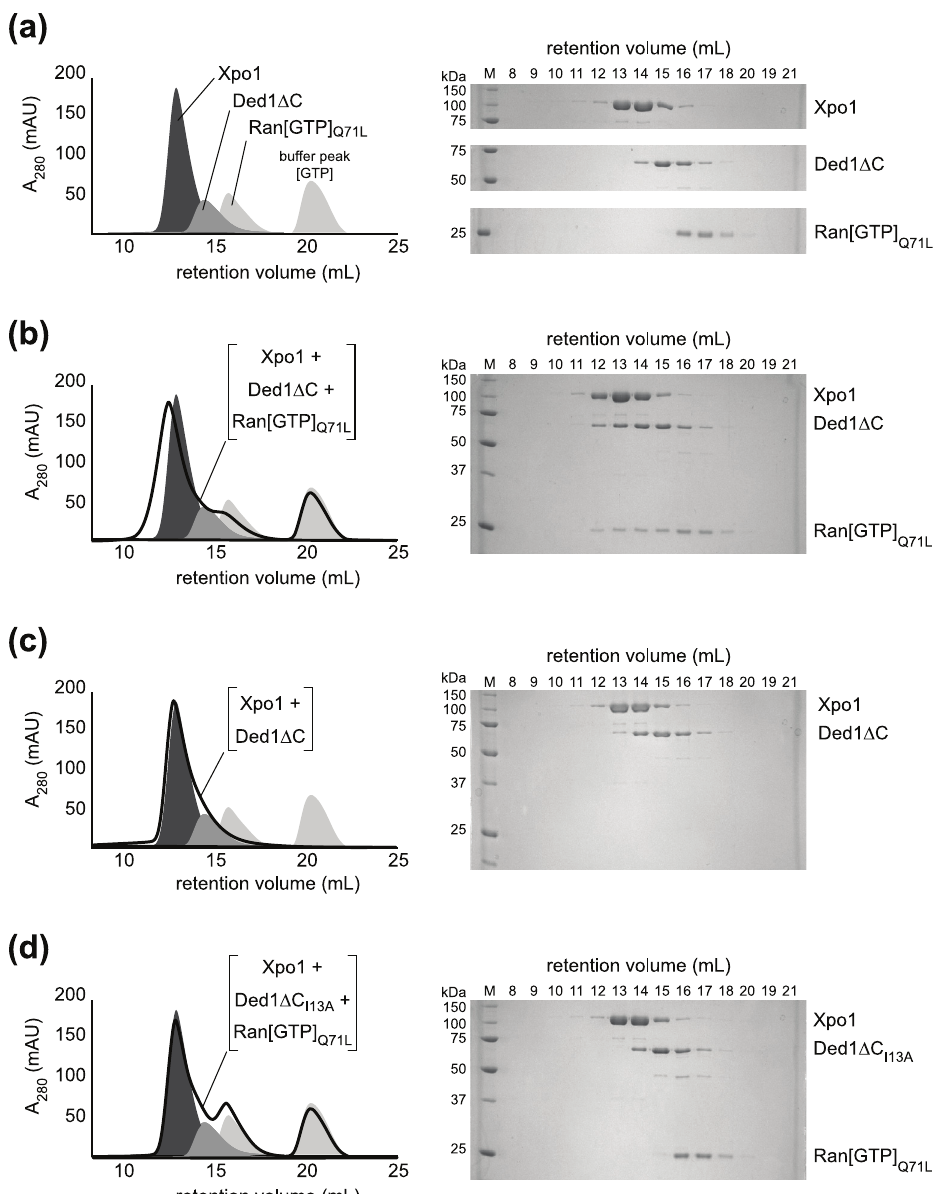
Fig 1. The NES of Ded1 Δ C is critical for a Ran[GTP]-dependent interaction with Xpo1. (a) The three protein components yield unique profiles by size exclusion chromatography. The profiles for each component applied individually on a Superdex 200 10/300 column are overlaid for comparison: Xpo1 (dark gray), Ded1 Δ C (medium gray), and Ran[GTP] Q71L (light gray). The second, larger peak in the Ran[GTP] Q71L profile is excess GTP included in the injected sample. Analysis of each experiment is also shown by SDS-PAGE, illustrating the distribution of peak fractions of each protein in isolation. (b) Xpo1, Ded1 Δ C and Ran[GTP] Q71L form a complex. The elution profile for Xpo1, Ded1 Δ C and Ran[GTP] Q71L co-incubated together before injection is shown as a black trace. The three solid gray peaks of the individual components, as shown in (a), are given for comparison. As shown in the chromatogram and by SDS-PAGE, all three proteins elute in earlier fractions when co-incubated together, consistent with a higher molecular weight complex. (c) Ded1 Δ C and Xpo1 do not form a stable complex without Ran[GTP] Q71L . The elution profile for Ded1 Δ C and Xpo1 co- incubated together before injection is shown as a black trace. The three solid gray peaks of the individual components, as shown in (a), are given for comparison. As shown in the chromatogram and by SDS-PAGE, Ded1 Δ C and Xpo1 elute at similar volumes as when they are injected individually, suggesting that a stable complex is not formed. (d) Ded1 Δ C I13A does not form a complex with Xpo1 and Ran[GTP] Q71L . The